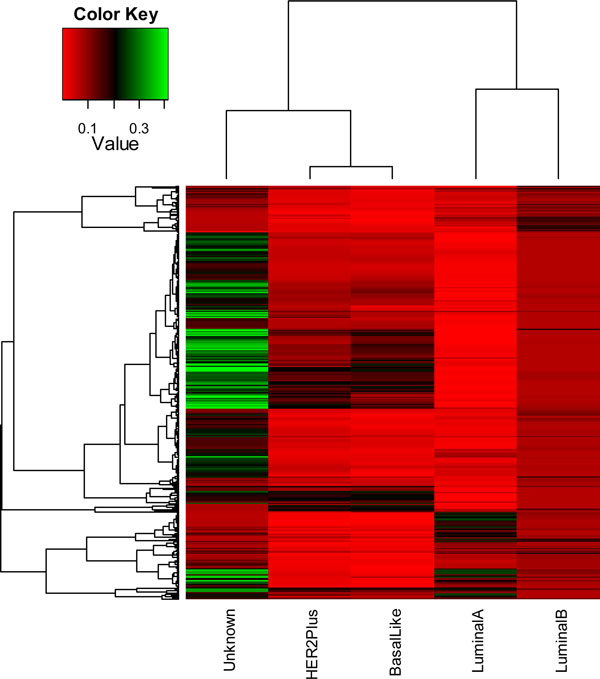
heatmap of q value across four subtypes (luminal A, luminal B, HER2+, and basal-like) and additionally unknown subtype. The y axis is protein markers. Each colored cell represents a Q value. The rows use hierarchical clustering with Euclidean distance. The columns use hierarchical clustering with Q-Value distance defined in the Equation (7).